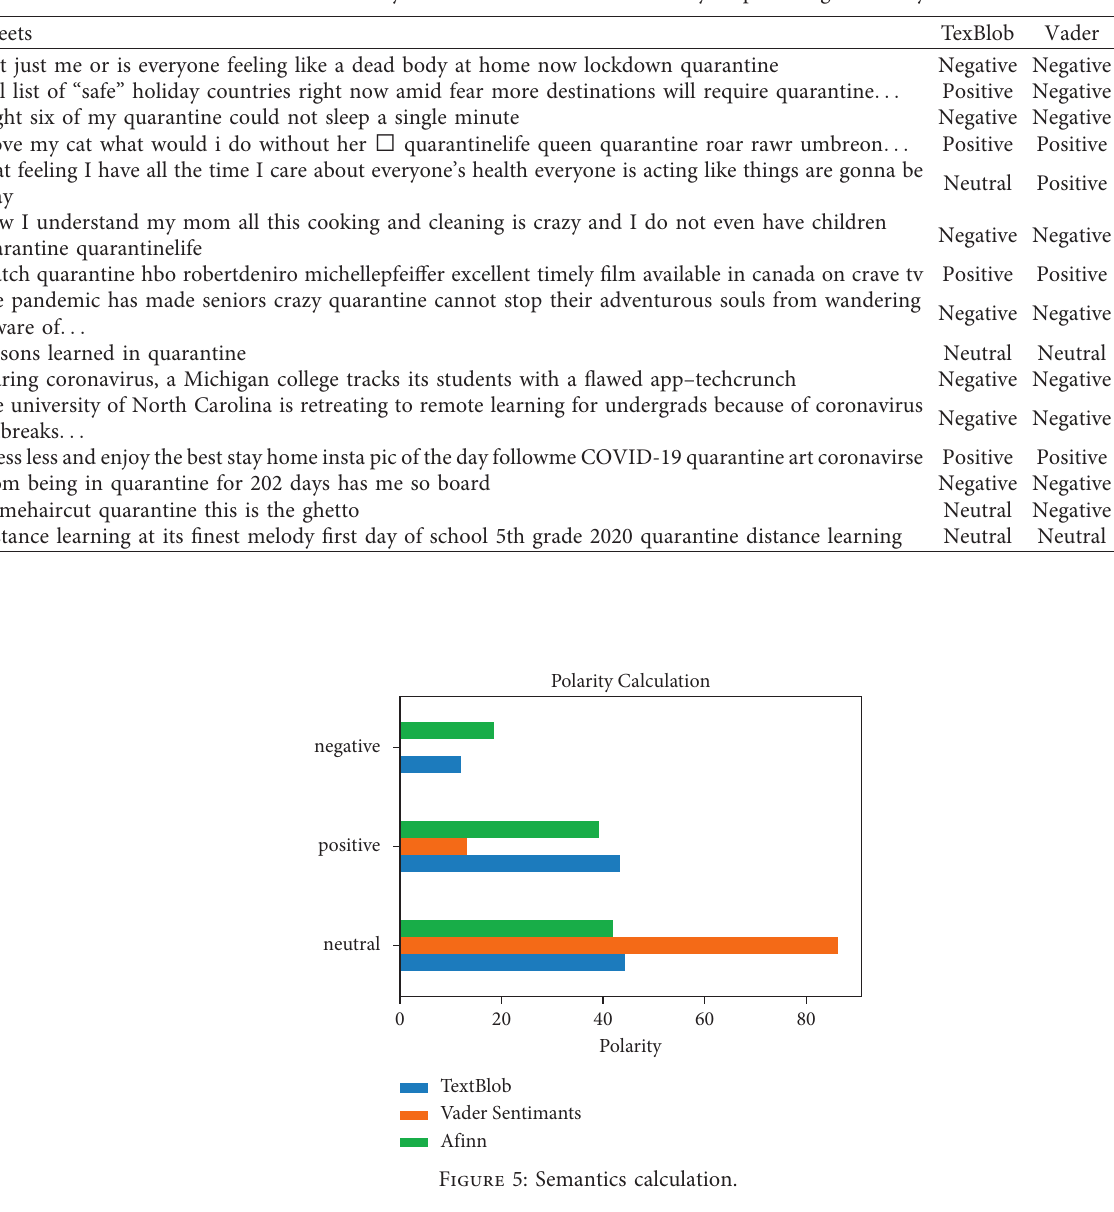
Table 1: Polarity calculation with sentiment analyzer percentage accuracy.